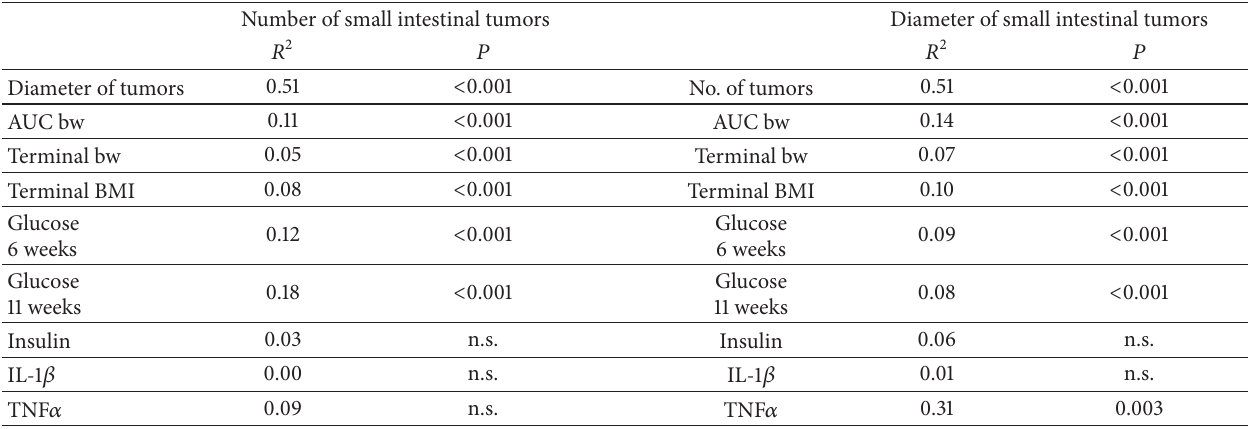
Associations between body weight parameters, glucose, insulin, and cytokine levels (independent variables) and the number or diameter of small intestinal tumors (dependent variables) were examined with simple linear regression (SigmaPlot 12.3, Systat Software Inc., San Jose, CA, USA). This was performed on pairs of end points from all mice from all experimental groups from which individual data could be paired. Number of small intestinal tumors is calculated as number of tumors in each mouse, and tumor diameter is calculated as mean of all tumors in each mouse. Body weight (bw) data were evaluated either as area under the curve from week 3 to 11 (AUC bw), as terminal bw, or as terminal body mass index (BMI) at 11 weeks of age. Nonfasted blood glucose was measured at 6 and 11 weeks of age. Insulin was measured with ELISA, and TNF 𝛼 was measured with flow cytometer, both in plasma obtained at termination at 11 weeks.